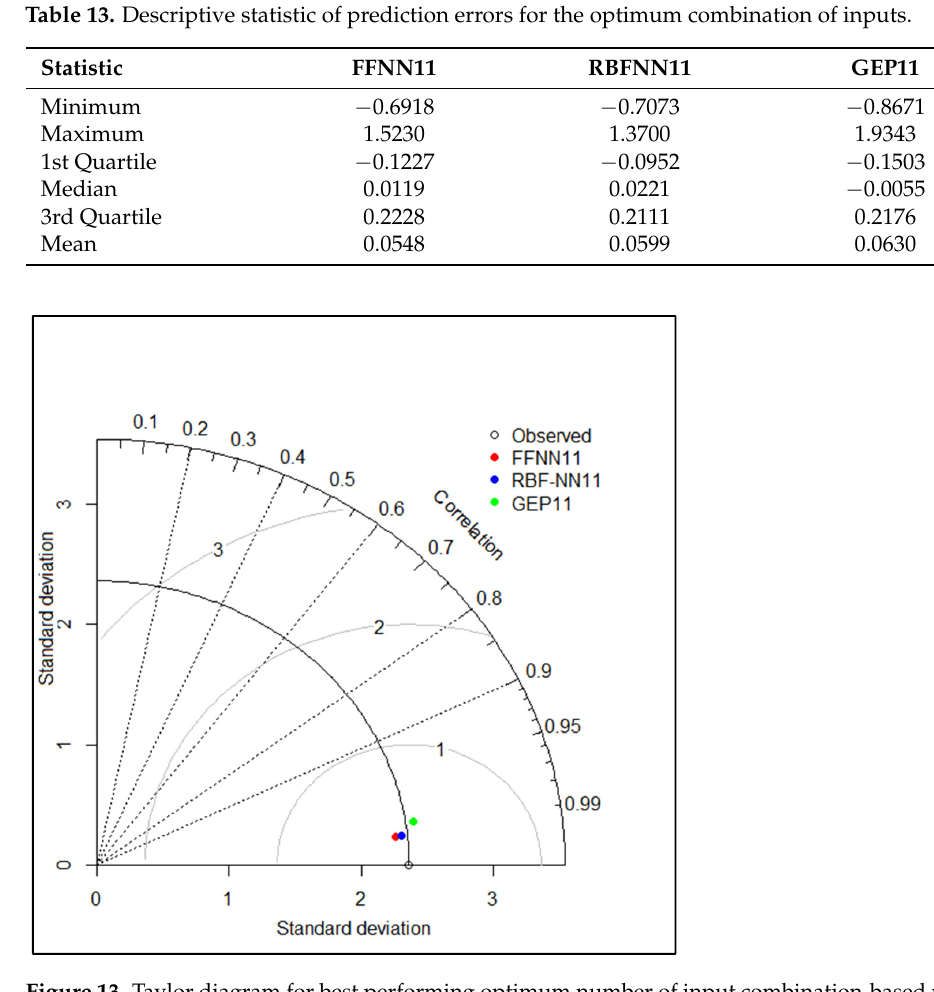
Figure 13. Taylor diagram for best performing optimum number of input combination-based models.